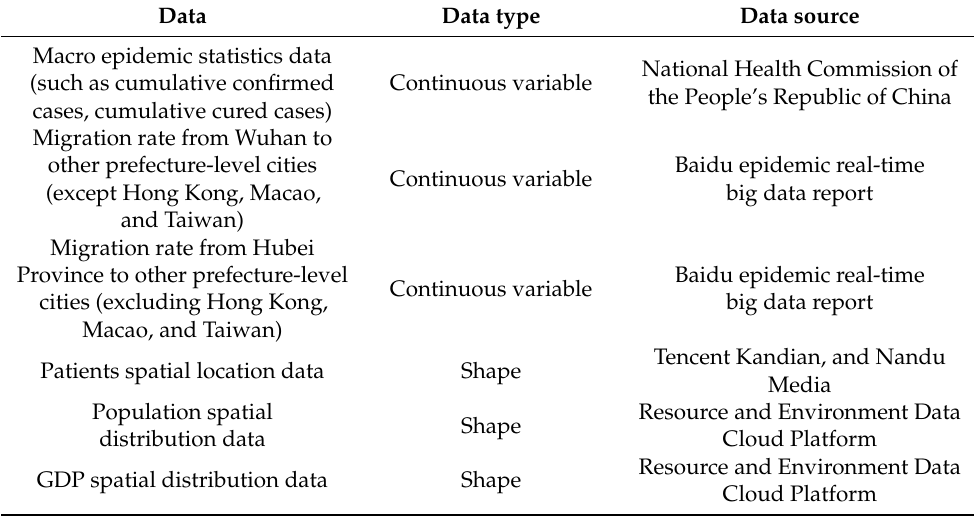
Table 1. Data used in the study.